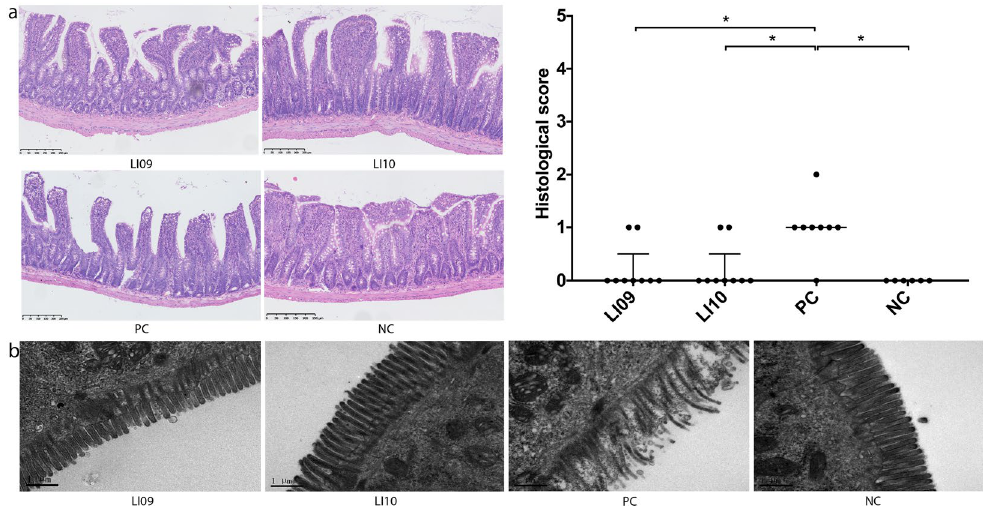
Figure 3. Effects of pretreatment with B. pseudocatenulatum LI09 or B. catenulatum LI10 on ileal histological abnormalities during D-GalN-induced acute liver injury. ( a ) Representative images of distal ileal H&E staining and histological scores of distal ileums based on these images. Values are expressed as the median with interquartile range. * p < 0.05 compared with the PC group. ( b ) Representative electron microscopy images of the distal ileum. Microvilli of the intestinal epithelial cells were